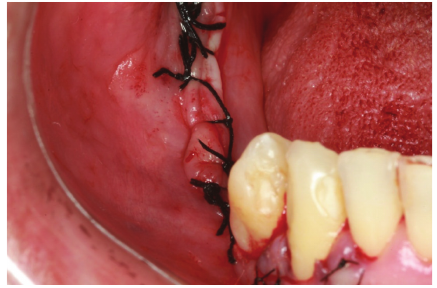
Figure 30: Suture.